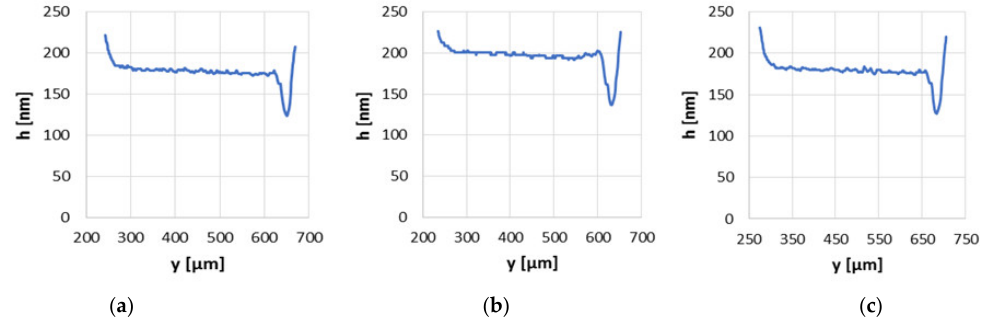
Figure 12. Oil film thickness distribution graphs in non-conformal contact with load of 30 N and sliding velocity of 0.2 m/s for the base surface ( a ), modified surfaces no. 2 ( b ) and no. 3 ( c ).